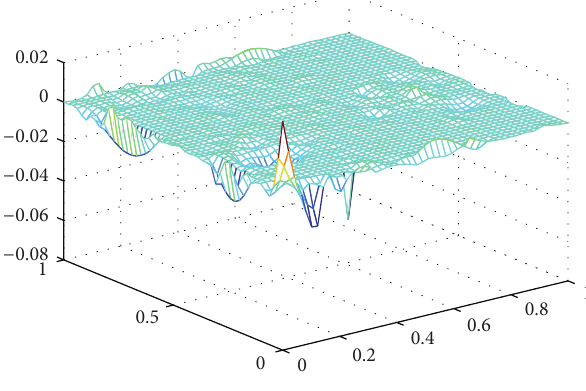
Figure 11: The error graph of 𝑄 𝑓 (𝑥,𝑦)